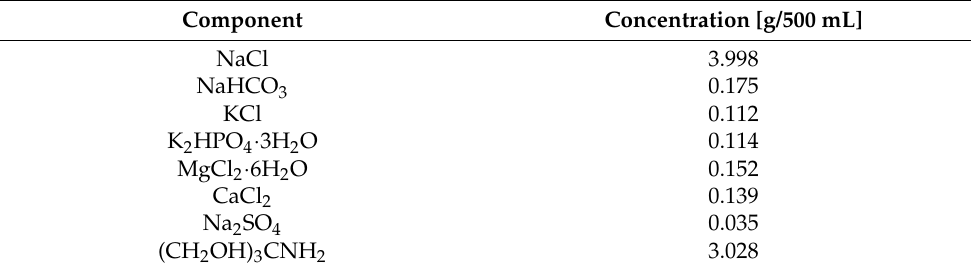
Table 1. Composition of the simulated body fluid (SBF)